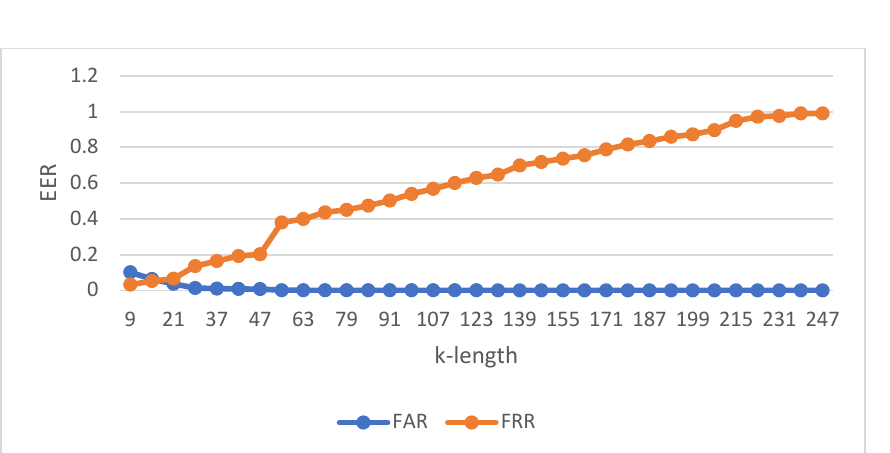
Figure 5. The results of EER for the BioIdent dataset with respect to k-length with n = 255.